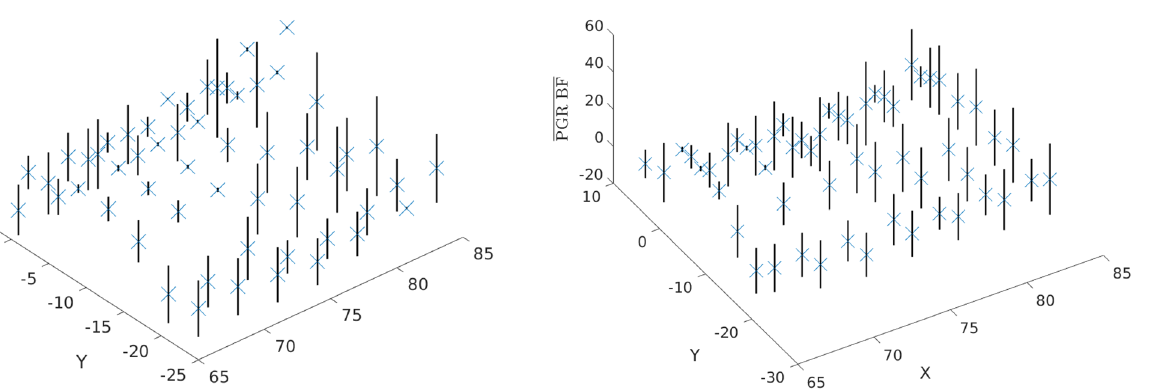
Fig. 20 PGR ( 𝐩 i ) and PGR s ( 𝐩 i ) , where poses consider variations in the full pose space, 𝐩 i ∈ ℝ 2